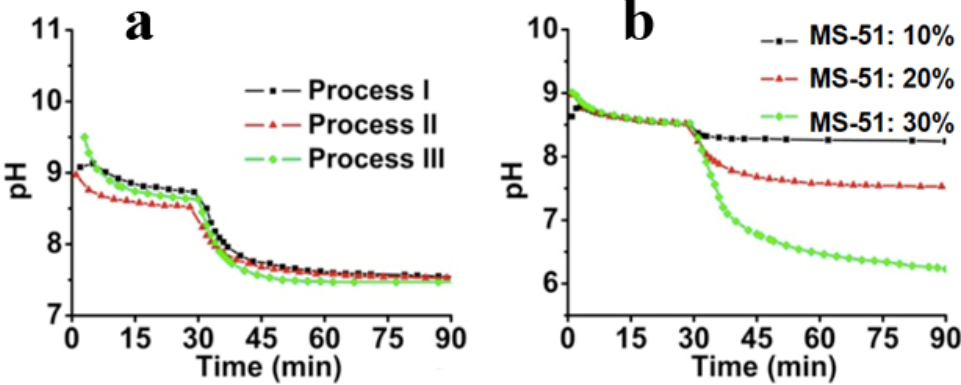
Figure 4. Time-course of pH change. ( a ) pH change curves under different cooling processes (different m ) by fixing 5 wt % LPEI and 10 vol % MS-51; ( b ) pH change ice curves under different concentrations of MS-51 by fixing 10 wt % LPEI in Process-II = 10 ( m ice